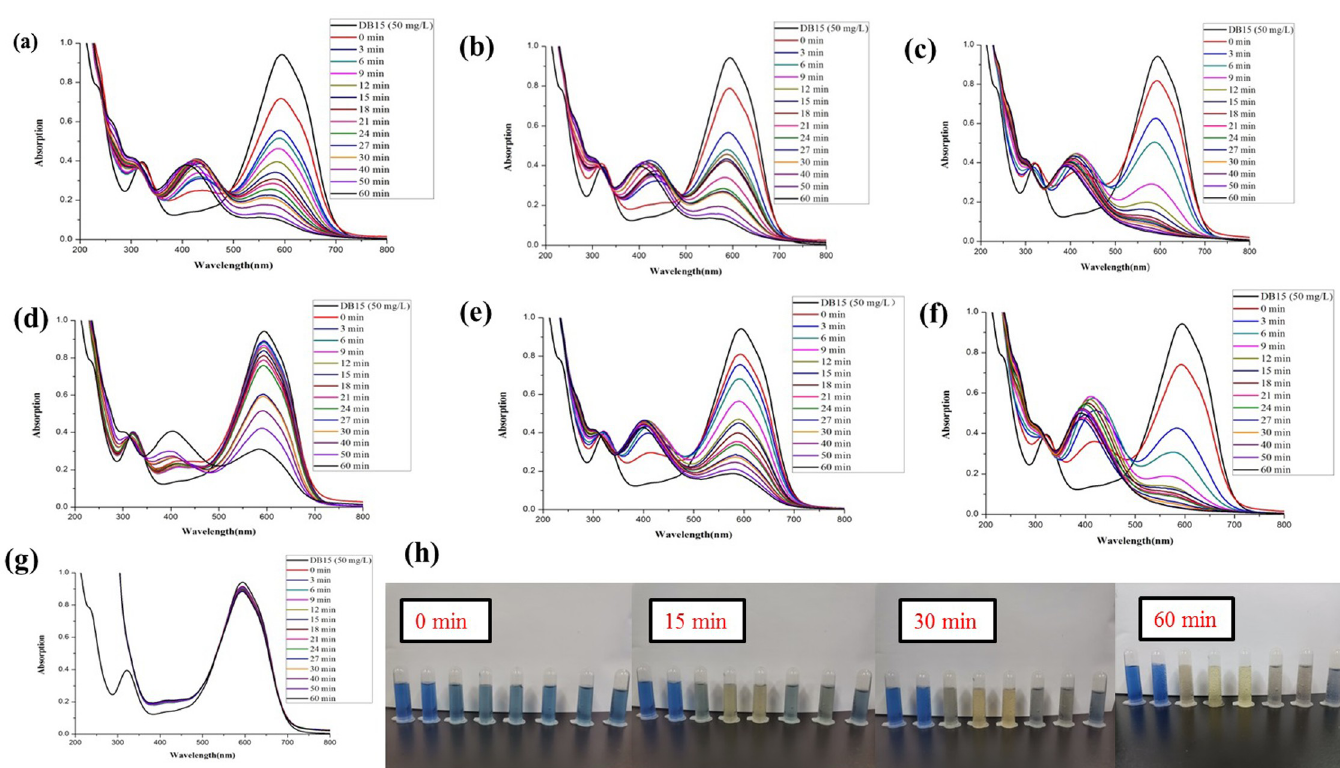
Fig 5. Comparison of the reductive degradation of Direct Blue 15 using different Z . officinale AgNPs synthesized from fresh ginger extracts: (a) unpeeled fresh ginger water extract AgNPs; (b) peeled fresh ginger water extract AgNPs; (c) fresh ginger peel water extract AgNPs; (d) unpeeled fresh ginger ethanol extract AgNPs; (e) peeled fresh ginger ethanol extract AgNPs; (f) fresh ginger peel ethanol extract AgNPs; (g) CK; (h) The solution appearance comparison of mixtures Z . officinale AgNPs and DB15 after reaction for 0, 15, 30 and 60 min. The solutions from left to right were followed as DB15 (50 mg/L), CK, unpeeled fresh ginger water extract AgNPs, peeled fresh ginger water extract AgNPs, fresh ginger peel water extract AgNPs, unpeeled fresh ginger ethanol extract AgNPs, peeled fresh ginger ethanol extract AgNPs, and fresh ginger peel ethanol extract AgNPs.